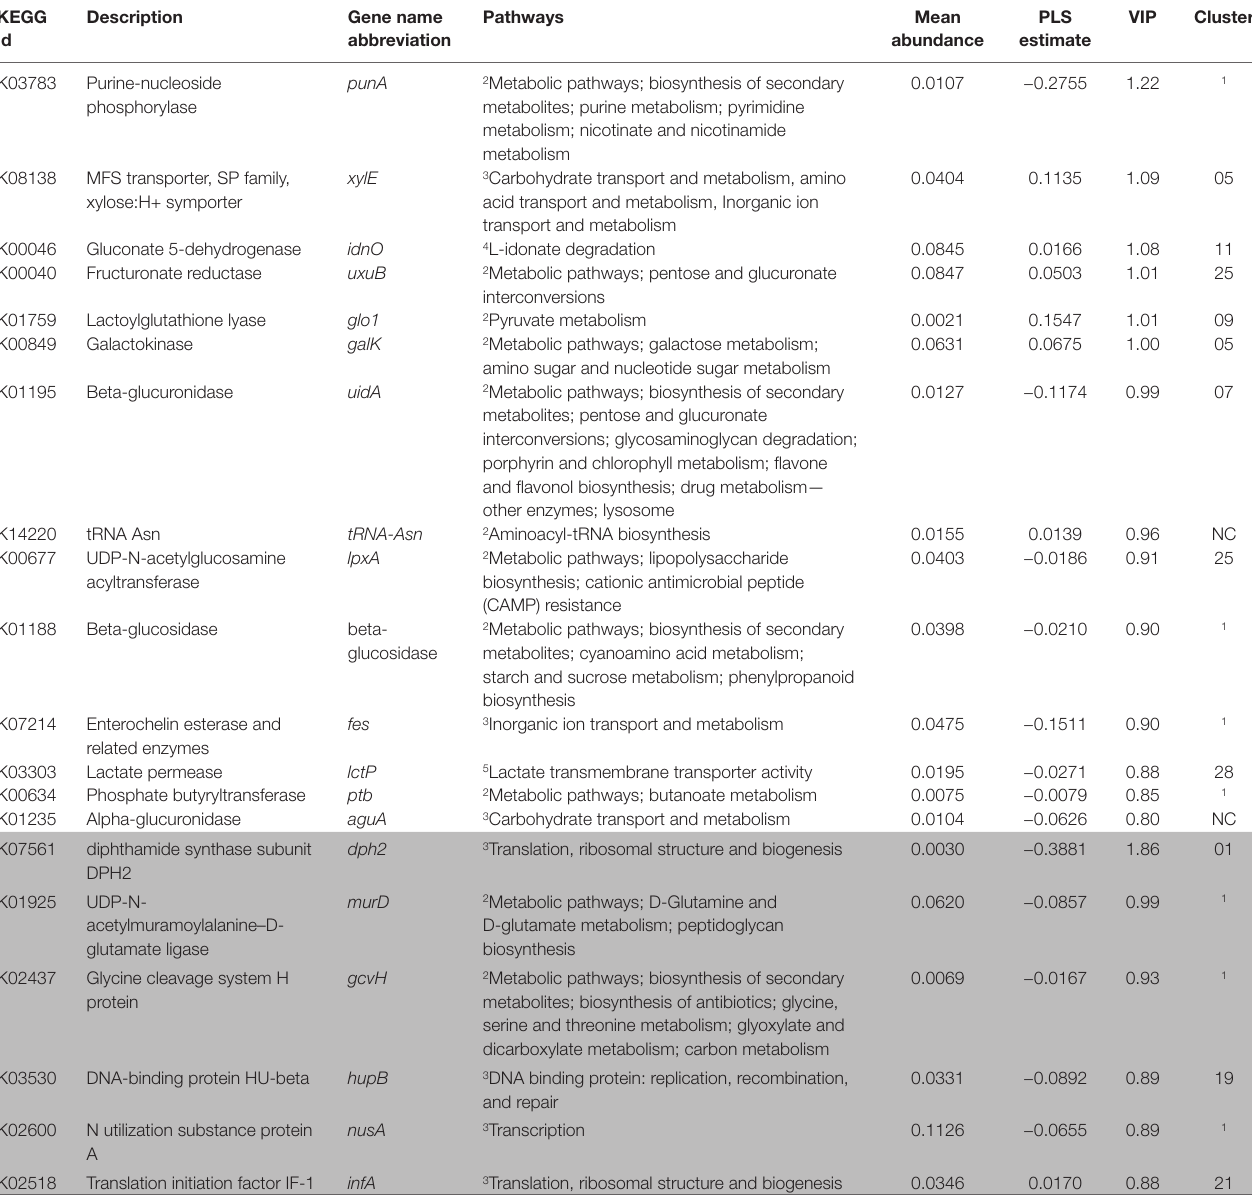
TABLE 2 | Summary of microbial genes identified for the prediction of